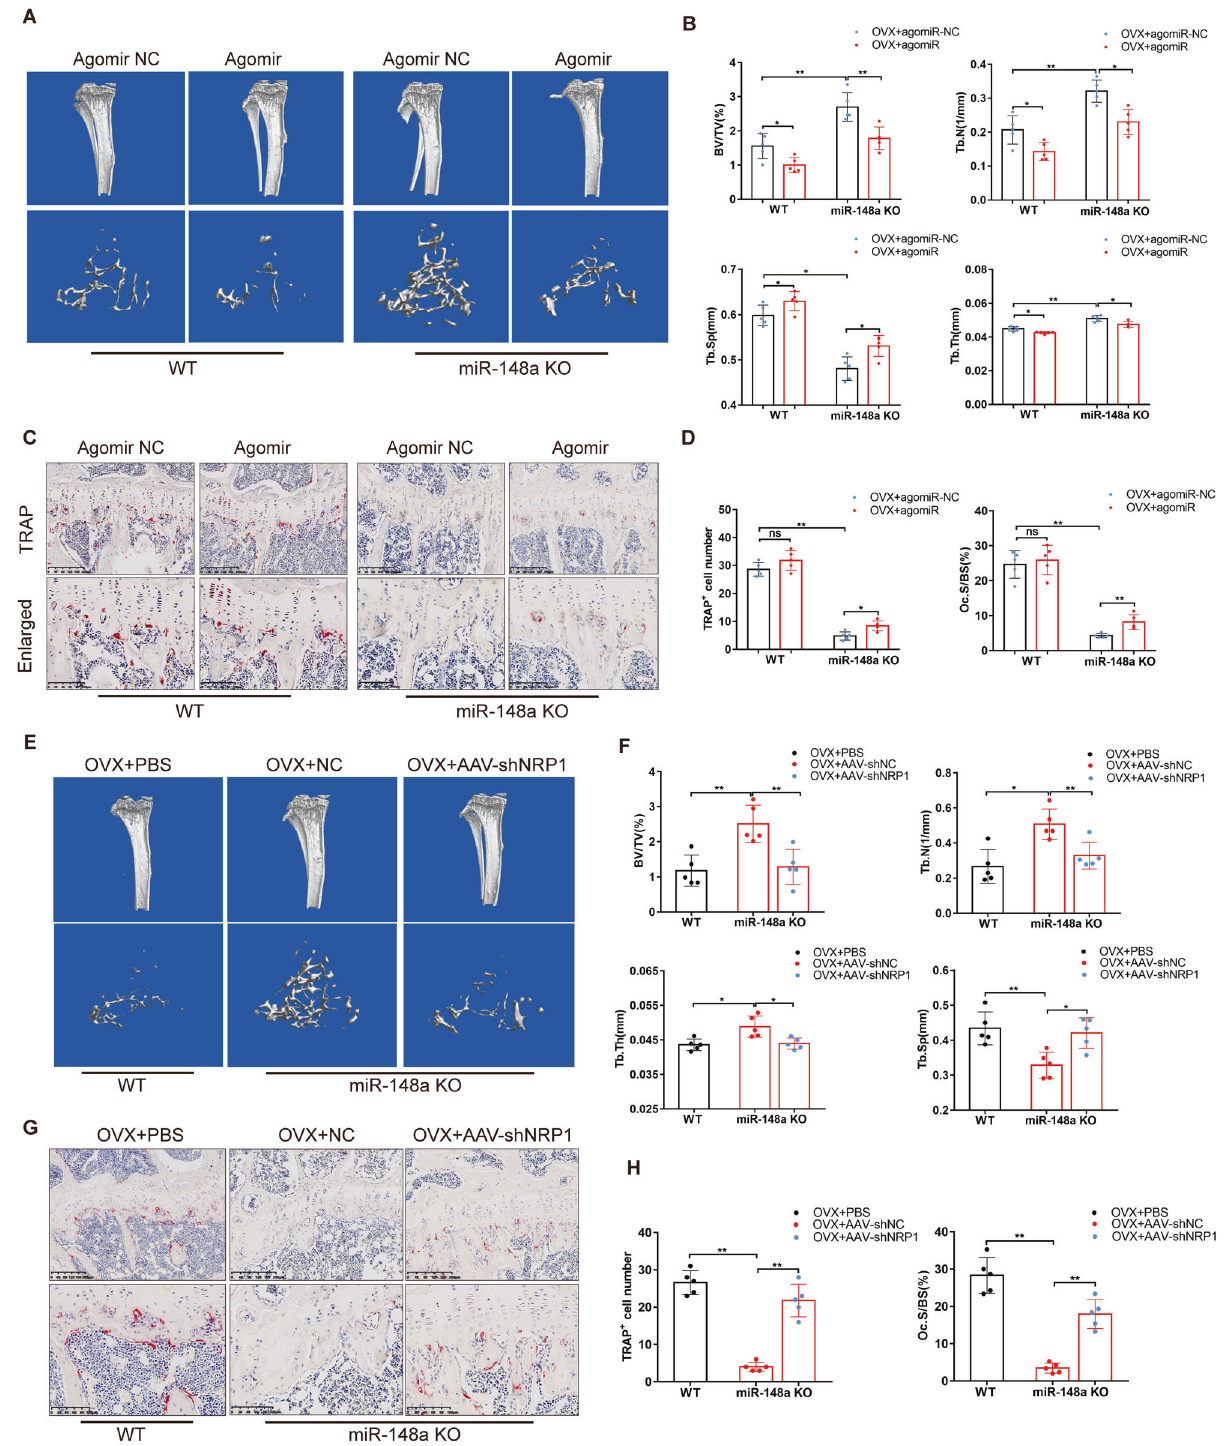
Fig. 7 miR-148a supplementation or AAV-shNRP1 reverses the bone protection phenotype of KO mice. A Representative μ CT 3D reconstructed images of tibiae from four groups (WT and KO mice suffered from OVX and supplemented with agomiR-148a and agomiR-NC, respectively). B Quantitative analysis of the trabecular bone parameters in A ; n = 5. C Representative images of TRAP staining from four groups above, Scale bar, 200 μ m. D Quantitative analysis of the number of TRAP-positive cells and the percentage of osteoclast surface per bone surface (Oc.S/BS); n = 5. E Representative μ CT 3D reconstructed images of tibiae from three groups OVX mice (WT-PBS injection, KO-shNC injection, and KO-shNRP1 injection). F Quantitative analysis of trabecular bone parameters in E ; n = 5. G TRAP staining of tibiae from the three groups above, Scale bar, 200 μ m. H Quantitative analysis of the number of TRAP-positive cells and the percentage of osteoclast surface per bone surface (Oc.S/BS), n = 5. (All data are presented as mean ± SD; * p < 0.05; ** p < 0.01; ns no signi fi cance, compared to the corresponding control group).